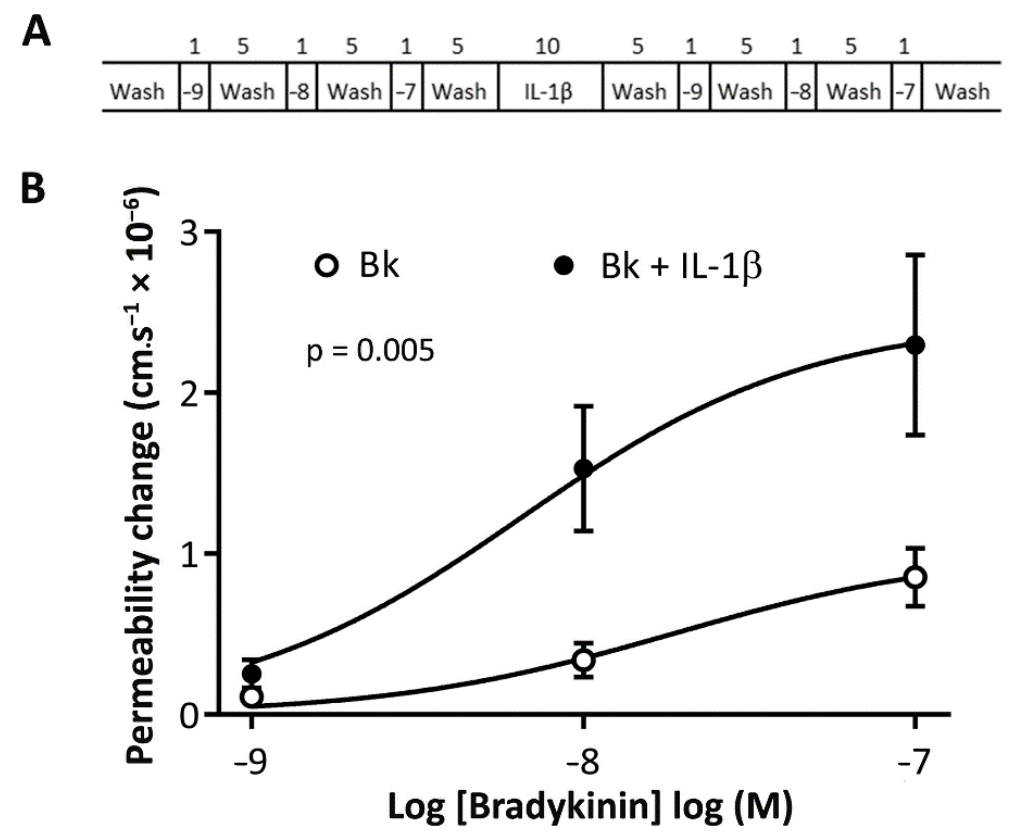
Figure 4. Acute treatment with IL-1 β potentiates bradykinin-induced microvascular permeability. ( A ) Experimental protocol for dose–response curves to bradykinin (Bk) in the presence of kininase inhibitors. Bradykinin dose–response curves were obtained in the absence of IL-1 β and after acute application of IL-1 β (30 pM) for 10 min, followed by wash-o ff and reapplication of bradykinin applications to the same post-capillary venule. The numbers in panel A indicate the time in minutes for each phase of the protocol. ( B ) Bradykinin permeability response curve following IL-1 β preapplication was significantly greater than all other responses. Data denote mean ± SEM of measurements in 8 vessels from 8 di ff erent animals, repeated measures, analysis of